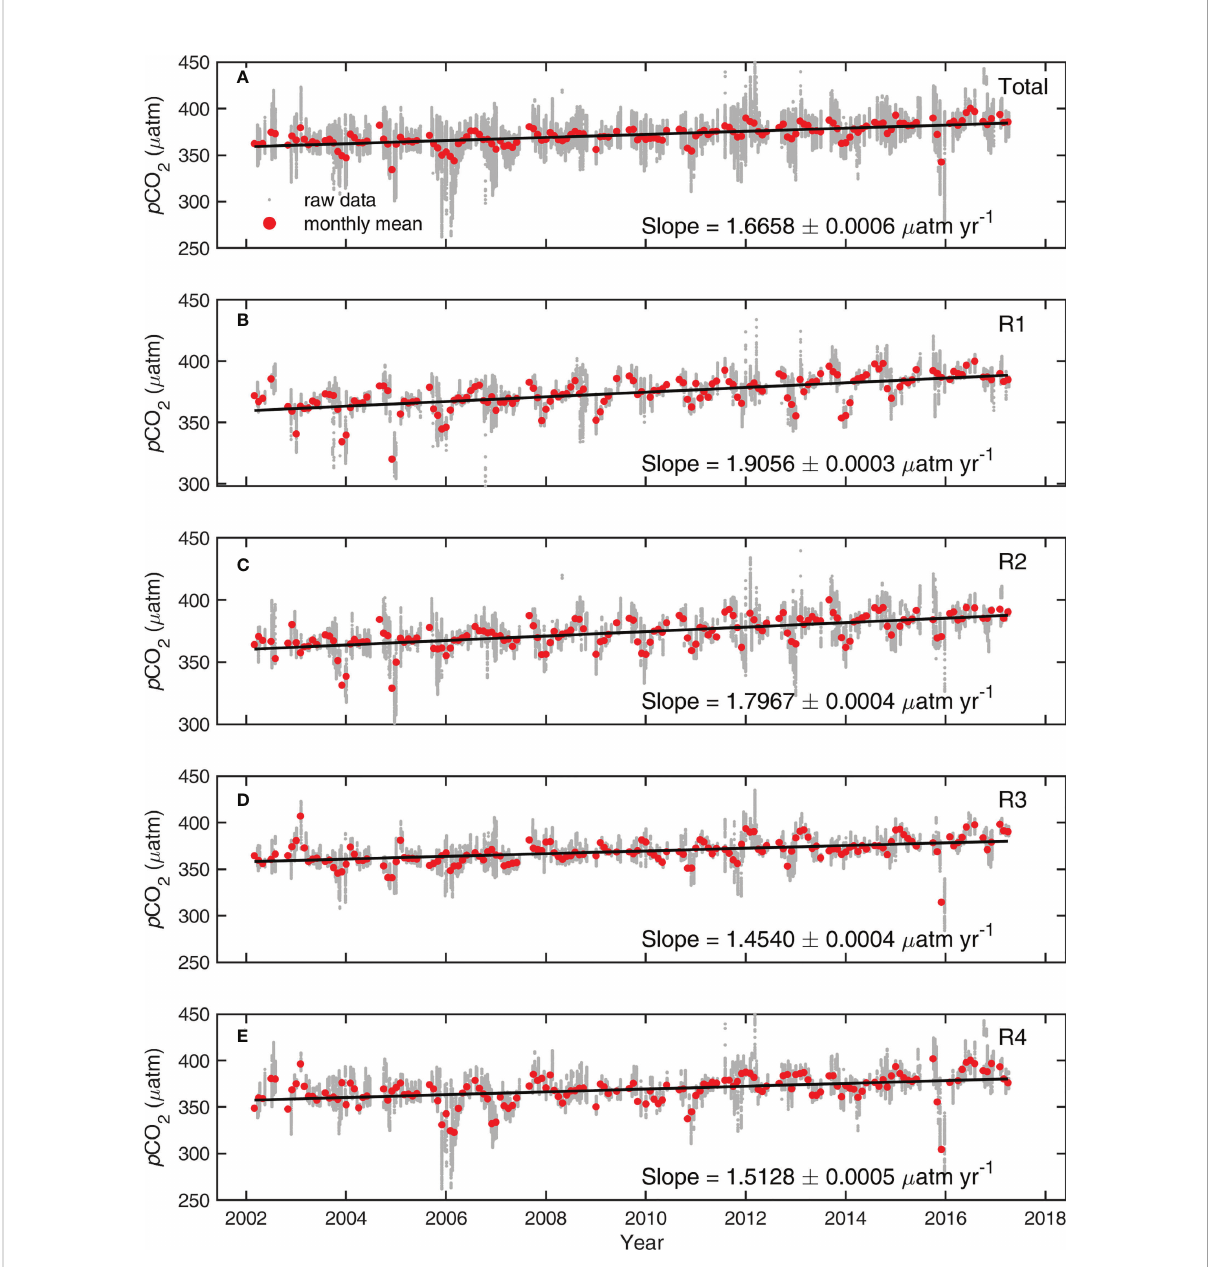
FIGURE 2 The inter-annual variation in surface p CO 2 in the Drake Passage (A) and speci fi cally in its four regions (B – E) The grey dots are the raw p CO 2 data, the red dots are the monthly mean p CO 2 values. The slope of linear regression is used to detrend surface p CO 2